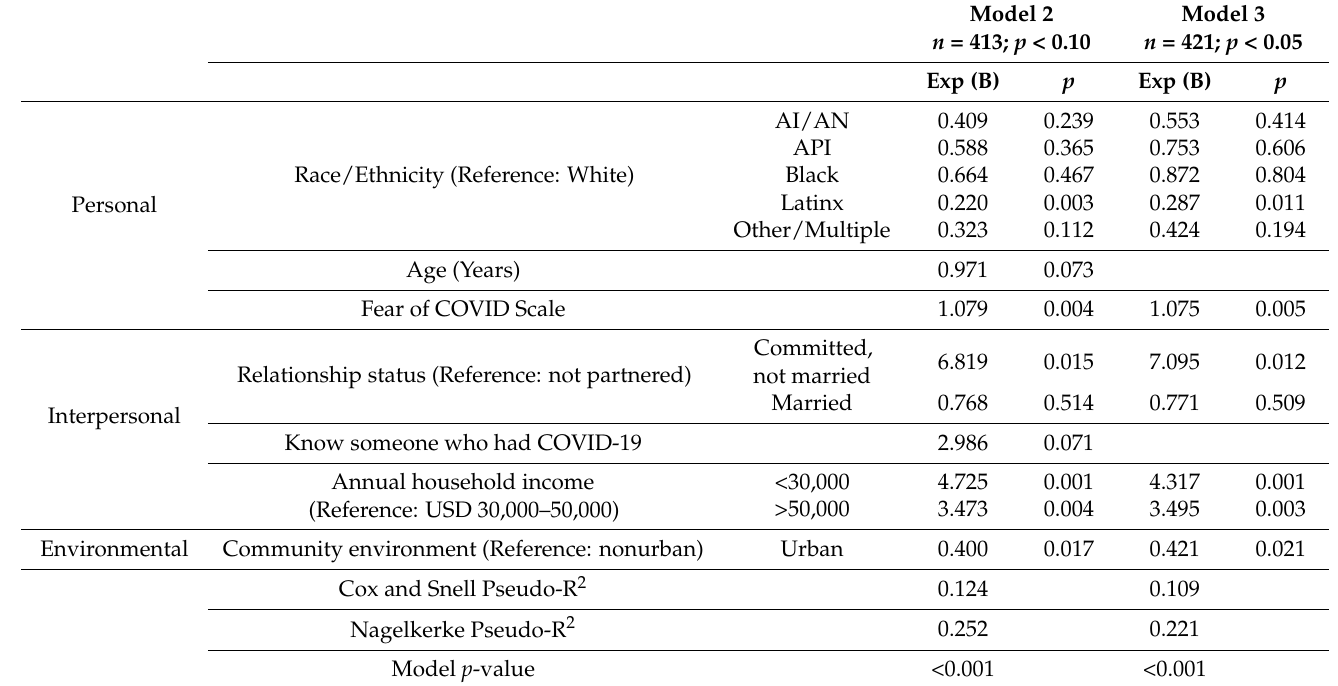
Table 3. Binary logistic regressions for outcome 1, staying home.